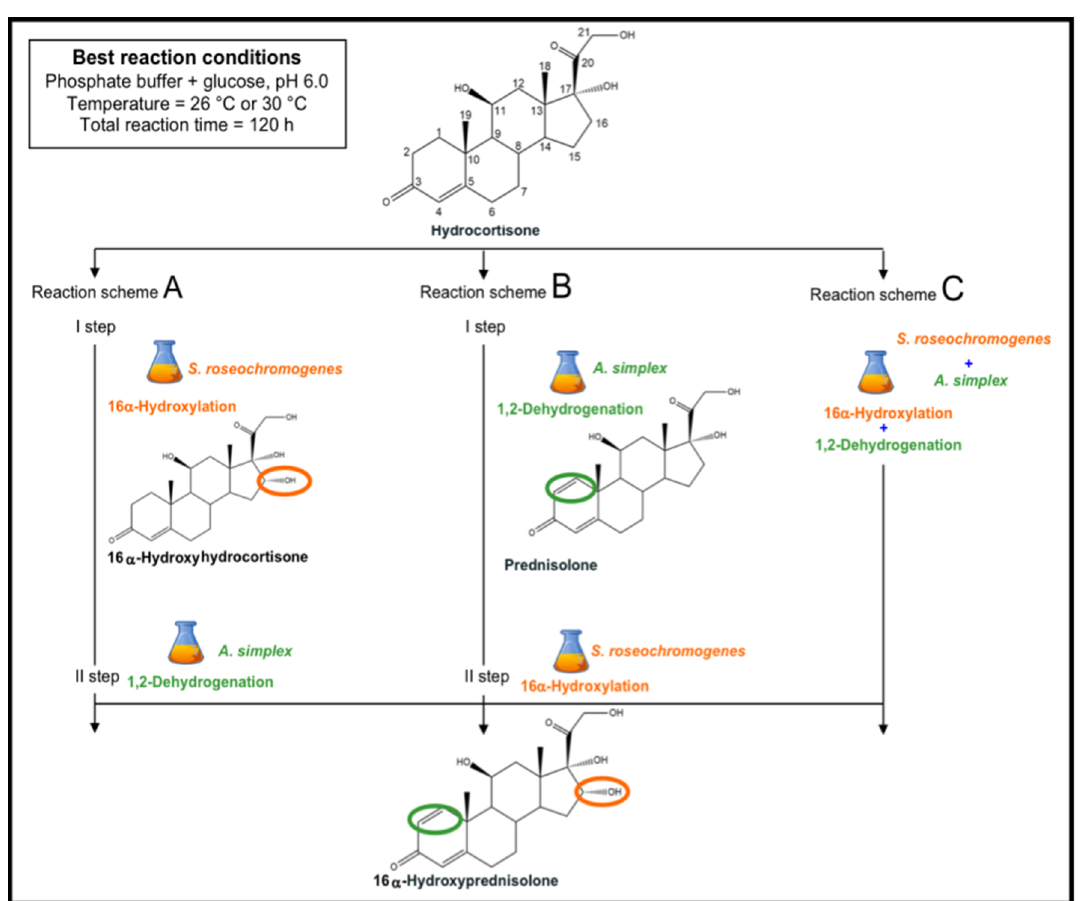
Figure 1. Possible reaction scheme to obtain 16 α -hydroxyprednisolone from hydrocortisone transformation by coupling the 1,2-dehydrogenation by A. simplex with the 16 α -hydroxylation by S. roseochromogenes : the two reactions might potentially be performed in a sequential mode in different order ( A , B ) or at the same time ( C ).